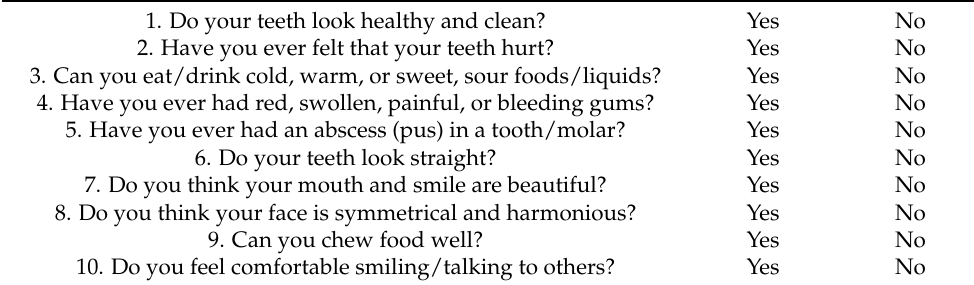
Table 1. Questionnaire